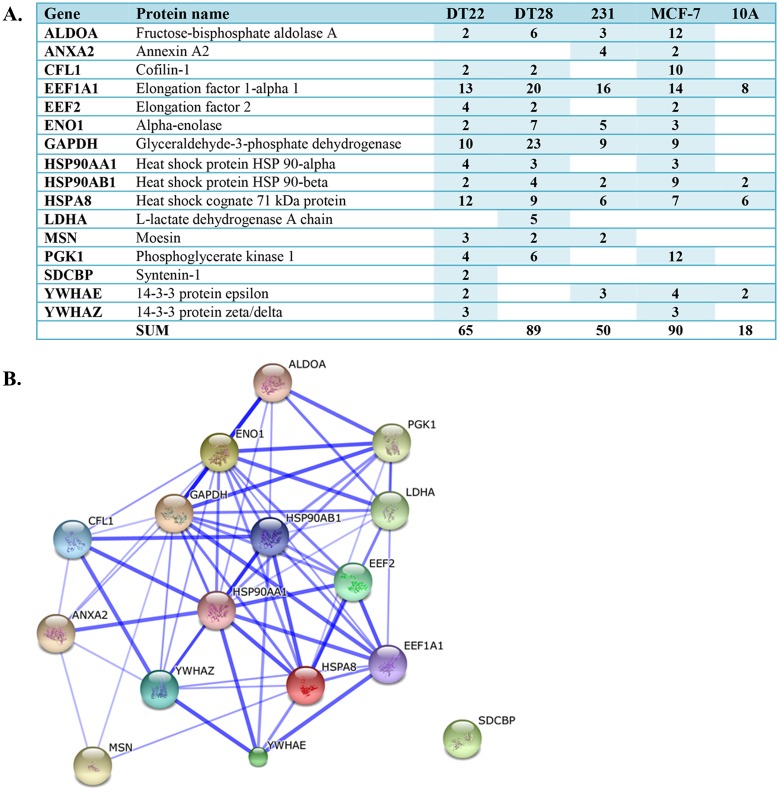
Putative exosomal proteins detected in the CM of BC and MCF-10A cells.A. The number of SCs identified in the CM of each cell line is indicated. MDA-MB-231 and MCF-10A cells are labeled as 231 and 10A, respectively. NSAF data can be found in S3 Table. B. STRING analysis illustrates the numerous complex interactions possible among the putative exosomal proteins. Thicker lines reflect a higher confidence score. (Abbreviations: CM = conditioned medium, BC = breast cancer, SC = spectral counts)